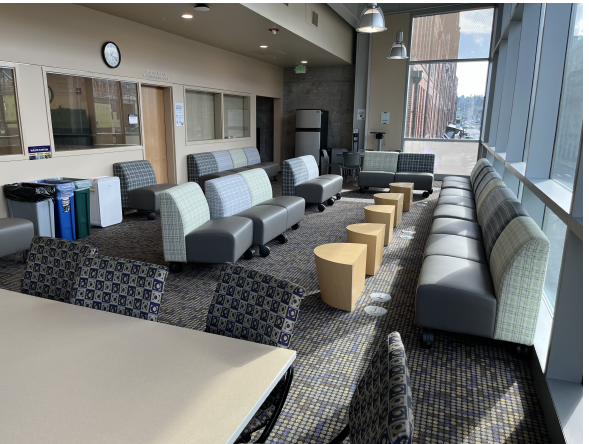
Figure 2. Photo of mixed use space at University of Washington that was used for range accuracy experiment as well as localization accuracy testing and characterization.